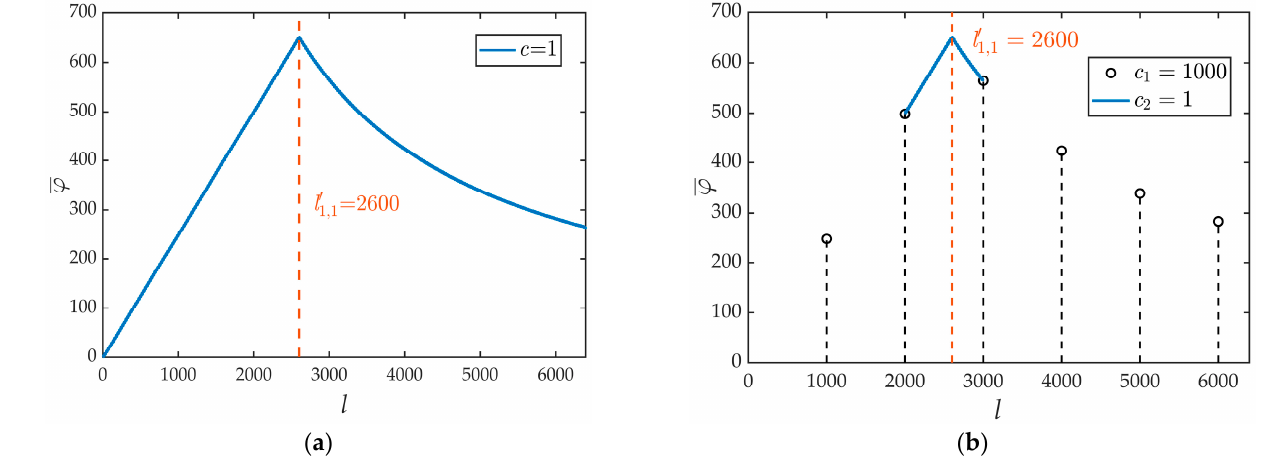
Figure 2. The variation of ϕ with l . ( a ) The variation of ϕ with l for an FH signal with an L of 6400 and l (cid:48) 1,1 of 2600 (the curve of the calculated ϕ with l when c = 1). ( b ) The curve of the calculated ϕ with l when c 1 = 1000 and c 2 = 1 .